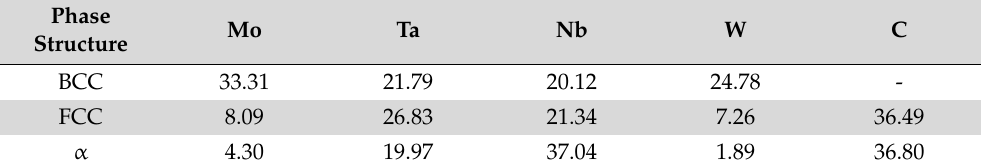
W0.7 and W0.9 represented distinct strain hardening at the initial deformation stage,